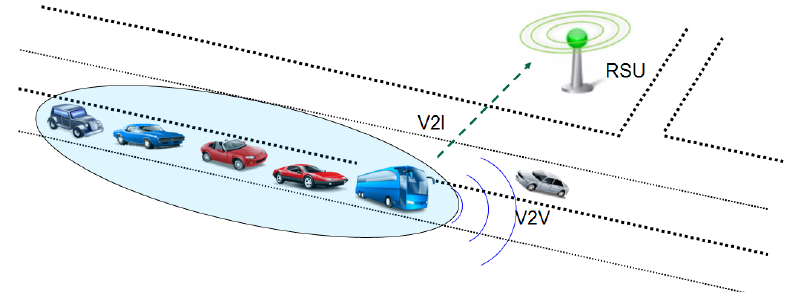
Figure 4. A platoon of